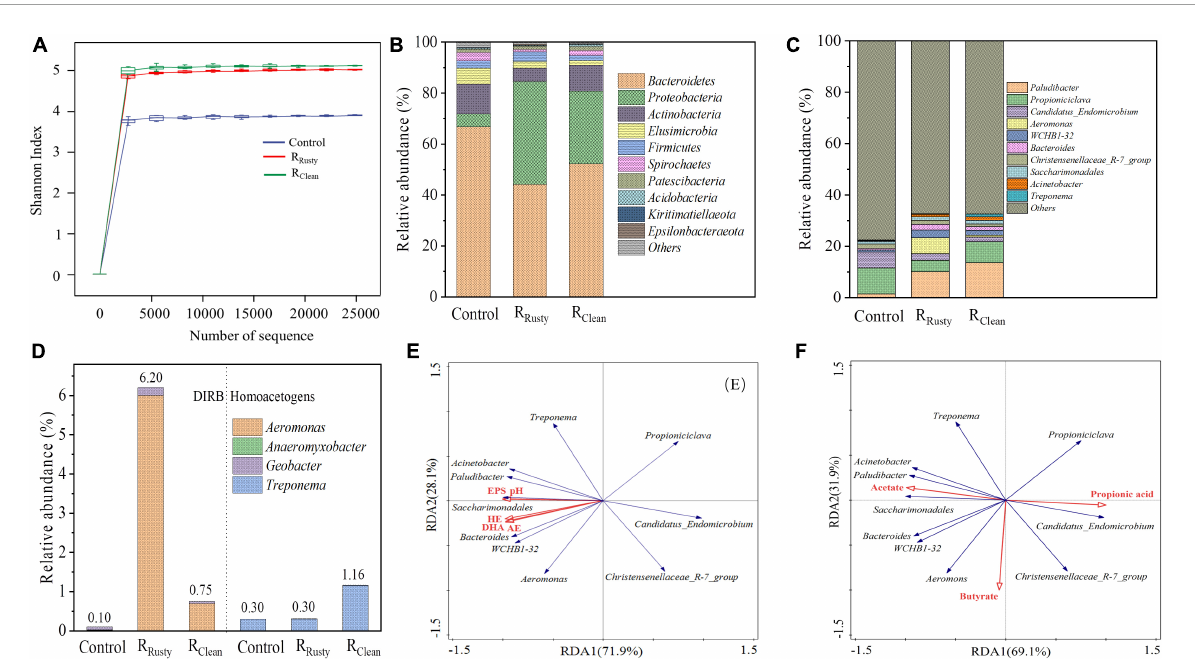
FIGURE3 Bacterial communities. (A) Shannon curves; (B,C) microbial community structure at the phylum and genus levels; (D) relative abundance of dissimilatory iron-reducing bacteria (left) and homoacetogens (right) in control, R Rusty , and R Clean systems; and (E,F) redundancy analysis revealed the correlation between the microbial community and environmental factors for sludge